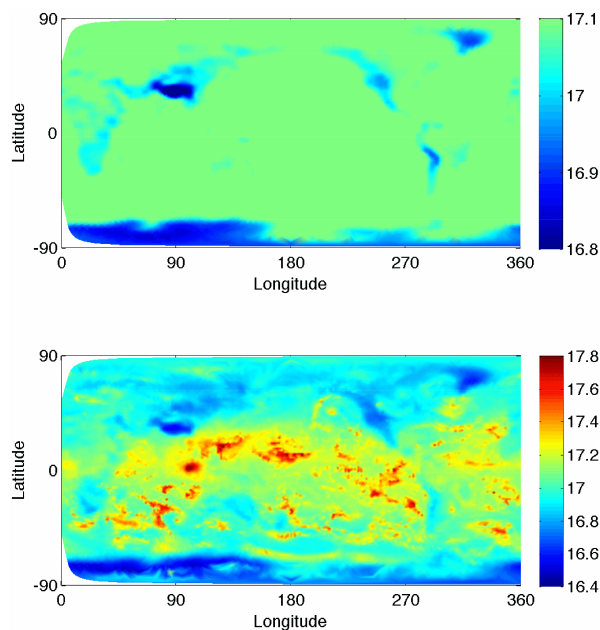
Figure 10. Logarithm of column resistance ((cid:127) m 2 ) for exponential conductivity (top) and WACCM conductivity